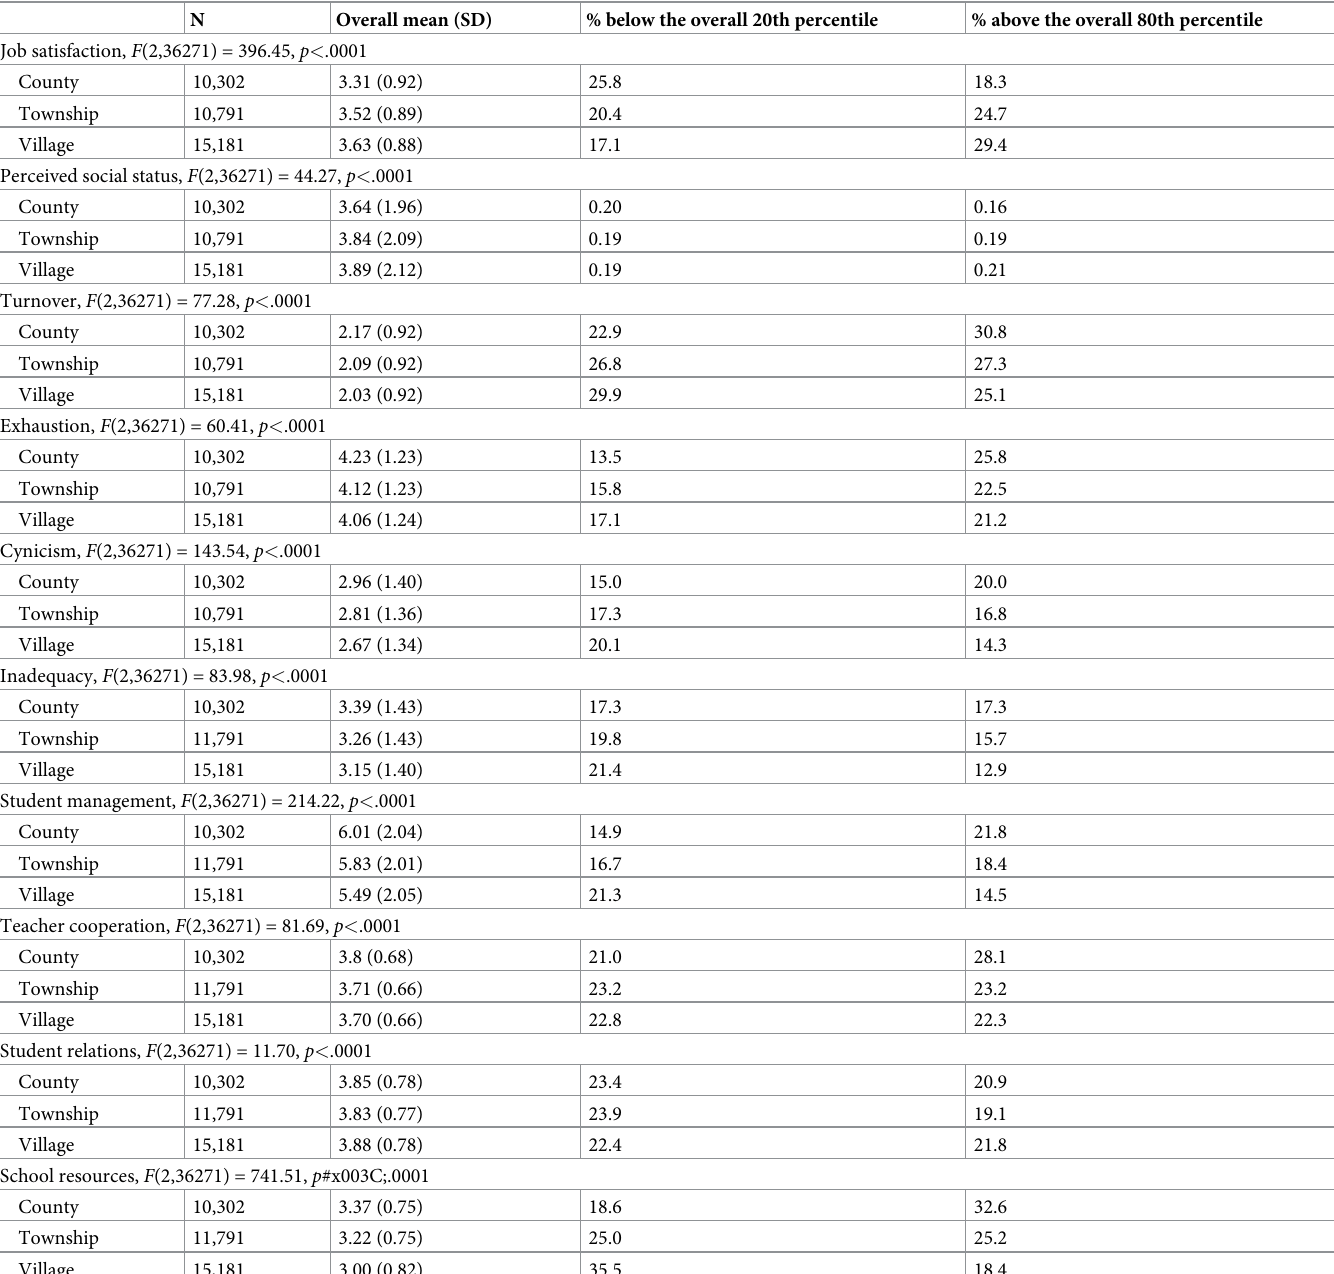
Table 10. Scores on selected scale variables of attitudes towards work by school location. N Overall mean (SD) % below the overall 20th percentile % above the overall 80th percentile Job satisfaction, F (2,36271) = 396.45, p <